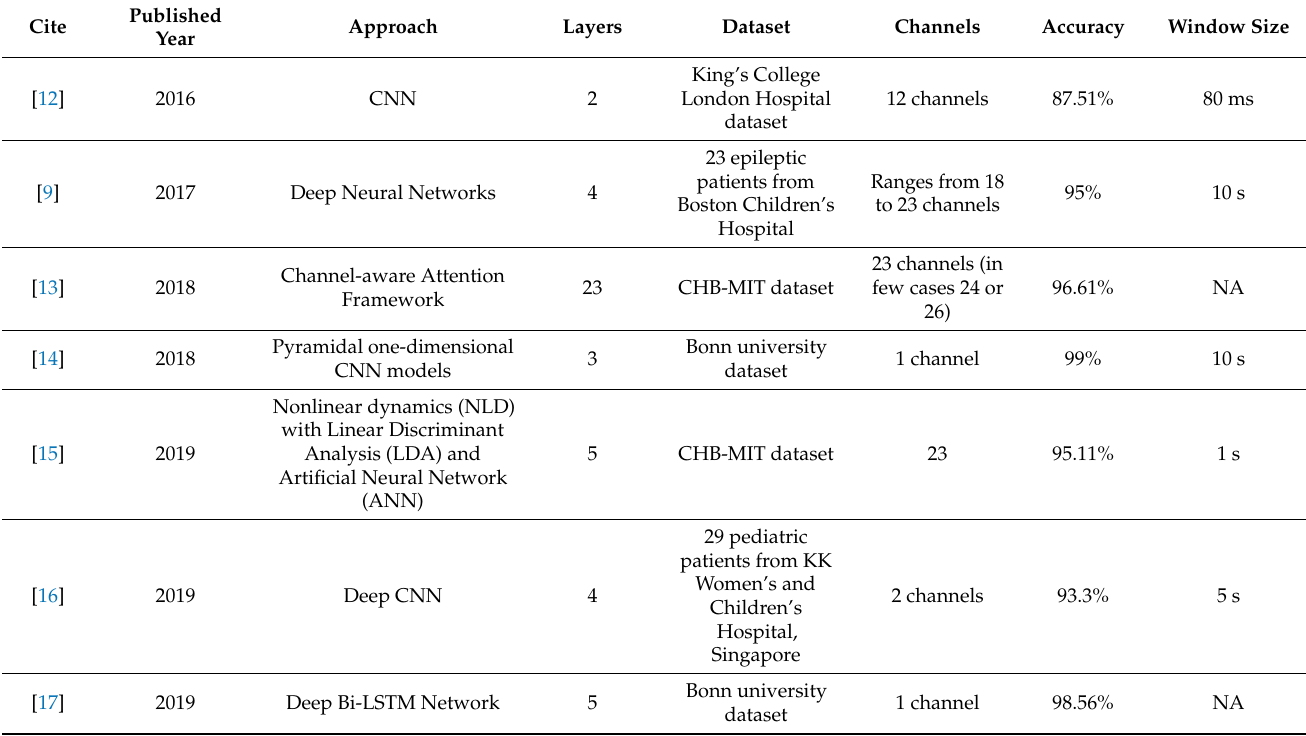
Table 2. EEG-based epileptic seizure detection systems using deep-learning